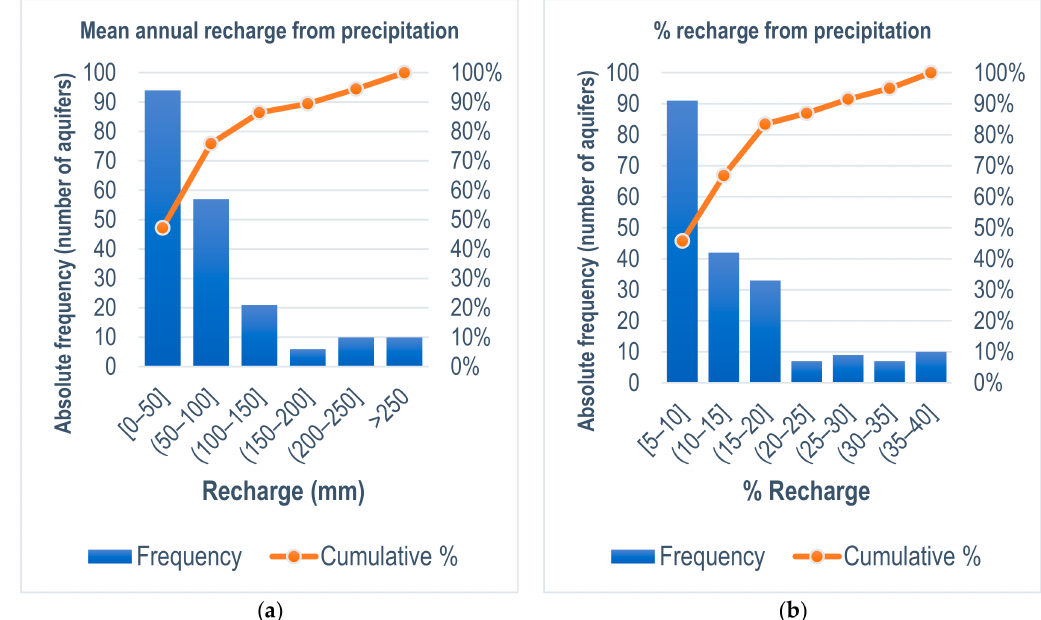
Figure 12. Histograms for the studied aquifers of ( a ) mean annual recharge from precipitation (mm) and ( b ) recharge from precipitation coefficients